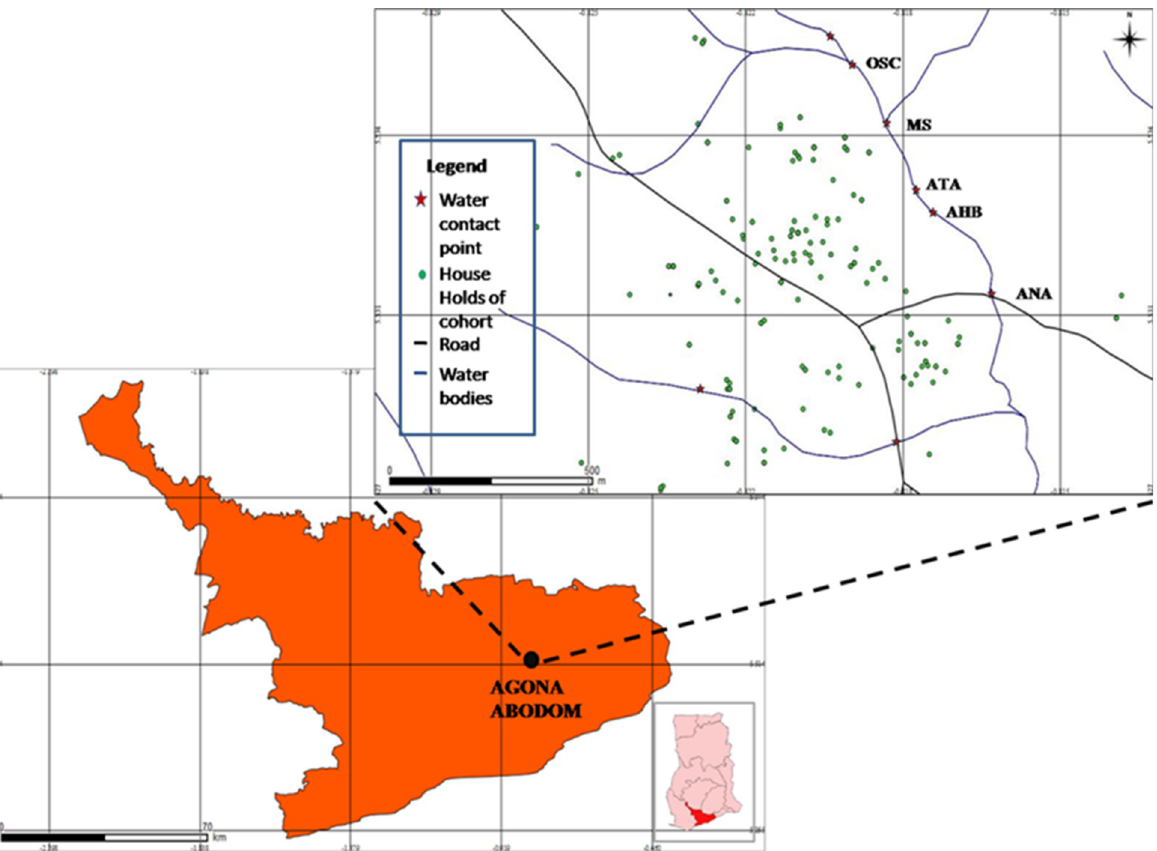
Fig 1. A map of the Central Region of Ghana with a zoom-in of the Agona Abodom community showing the spatial distribution of the water contact sites and houses of the 114 participants involved in the study. Map of the Central Region of Ghana is courtesy the Centre for Remote Sensing and Geographical Information Systems (CERSGIS), University of Ghana, Legon (2012). GPS data on households of study participants and water contact sites were plotted using the QGIS Valmiera 2.2 software (Essen, Germany, 2012). Legend of major water contact sites: OSC = Oworaa sika; MS = Mansowaa; ATA = Atifi Awombrew; AHB = Awombrew near High Blows Park; ANA = Anaafo Awombrew. Inset: Map of Ghana indicating the location of the Central Region. Figure was developed by Elias Asuming-Brempong.